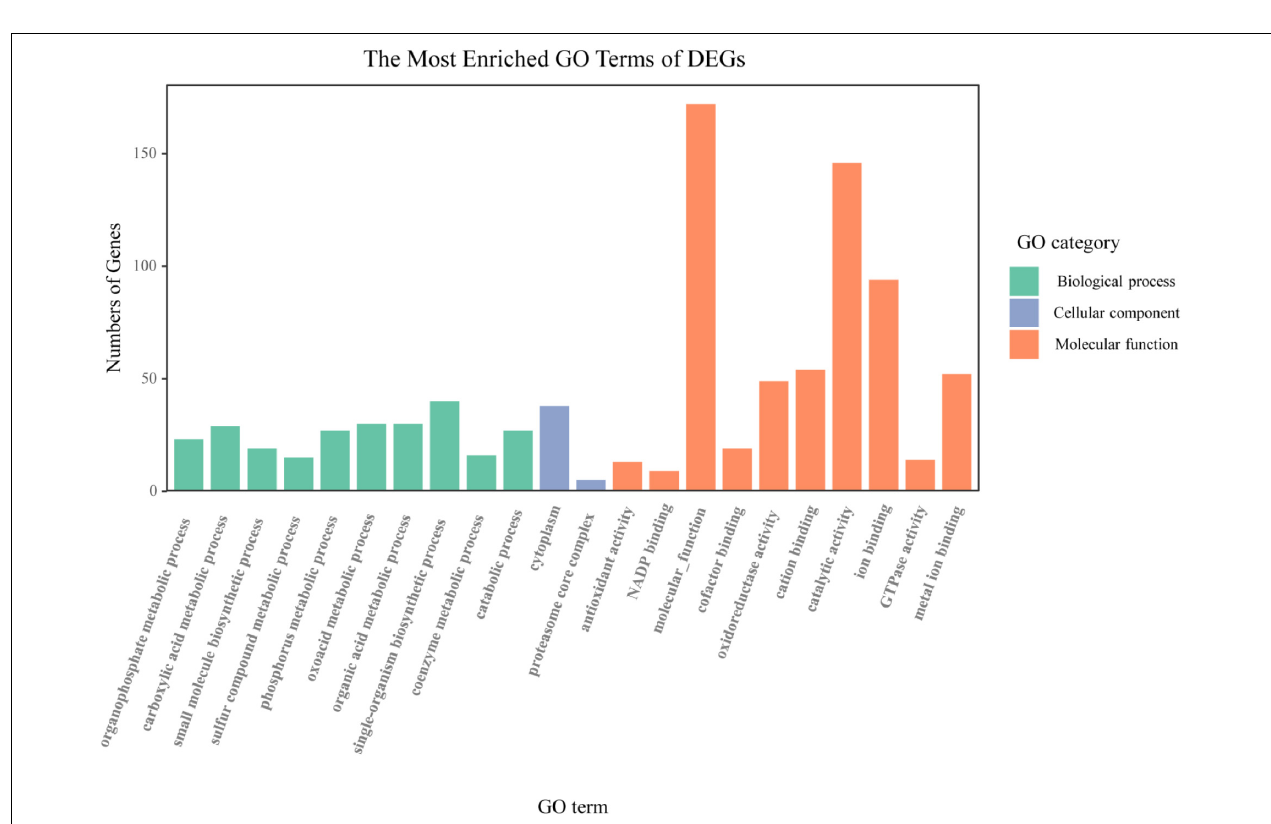
FIGURE 3 | Gene ontology (GO) enrichment analysis of the AM-induced genes regulated by indigenous microorganisms. The x -axis indicates various GO terms. The y -axis indicates the number of genes in GO terms. The color of column indicates the GO category to which GO term belongs.